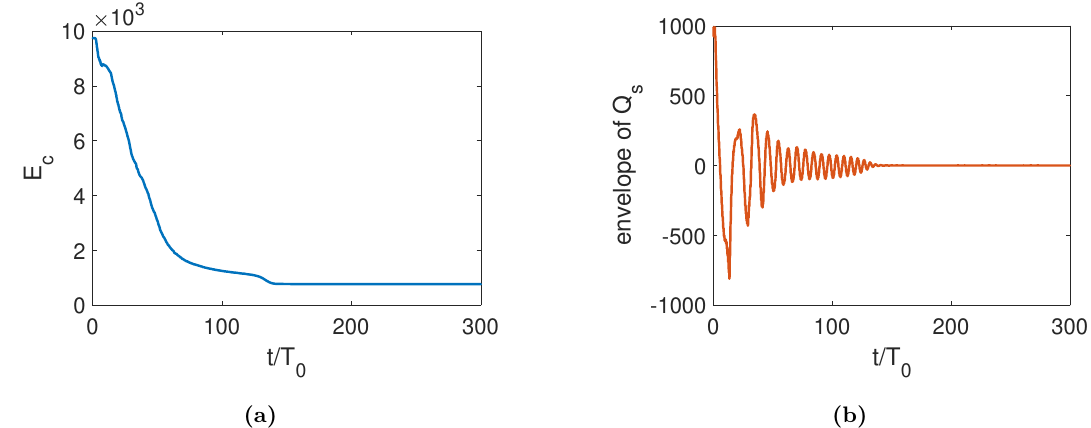
Figure 33. Energy (left) and charge (right) evolution of the octupole CSQ of figure 32. The parameters in the potential are chosen as g = 0 . 6 , ω = 0 . 84 , d = 3